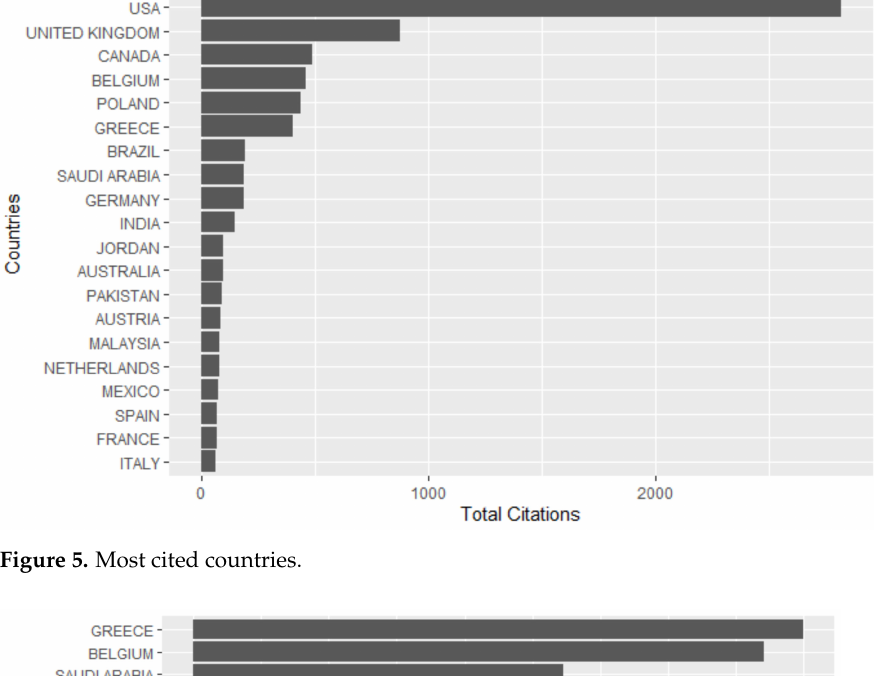
Figure 5. Most cited countries.